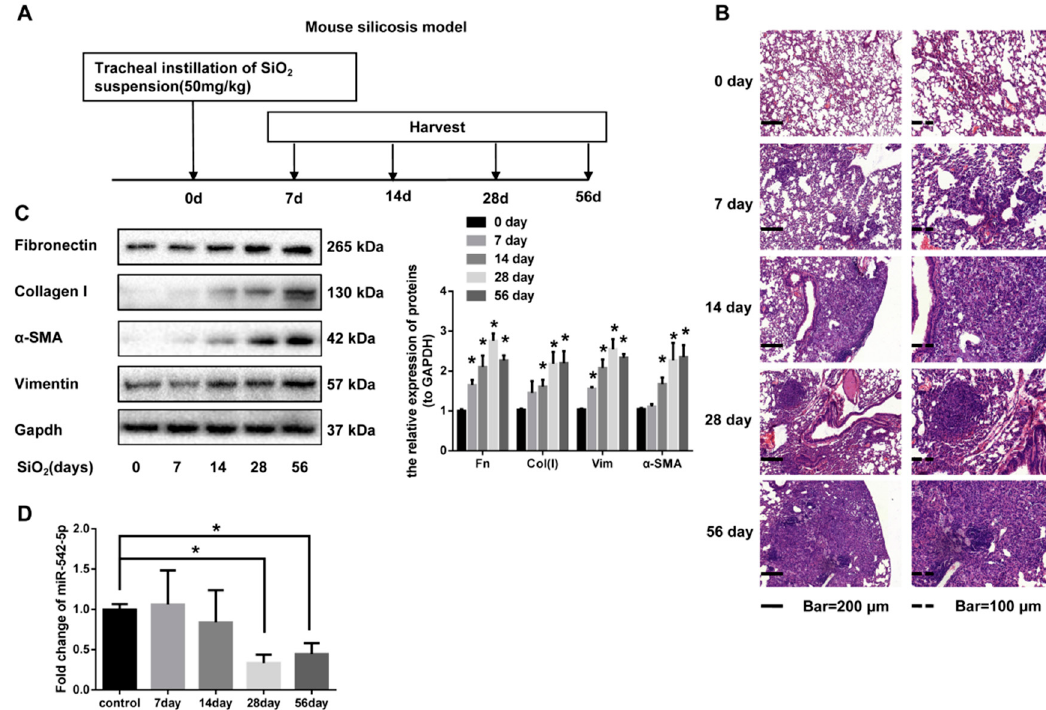
Figure 1. miR-542-5p is down-regulated in the lung tissues of mice with silicosis. ( A ) The mouse model of silicosis. The C57BL/6 mice were tracheally instilled with SiO 2 suspension (50 mg/kg) and then the tissues were harvested on days 7, 14, 28 and 56 after treatment ( n = 8 per group). ( B ) The hematoxylin and eosin staining of lung sections (from mice received silica treatment for 0, 7, 14, 28, 56 days) reflected the distribution and severity degree of silicosis and the most representative results were shown. ( C ) Proteins of lung tissues from three randomly selected mice in each group were extracted and Western blot was performed to detect the fibrosis markers (fibronectin, collagen I, α -SMA and vimentin). Fn: fibronectin; Col(I): collagen I; Vim: vimentin. ImageJ software was used to perform a grayscale scan, with semi-quantitating protein bands. GAPDH was used as the interval reference. ( D ) Total RNA of lung tissues (from mice received silica treatment for 0, 7, 14, 28, 56 days) were extracted and the expression level of miR-542-5p was examined by qRT-PCR. U6 was used as the interval reference. Above all, * p < 0.05 versus the control group.